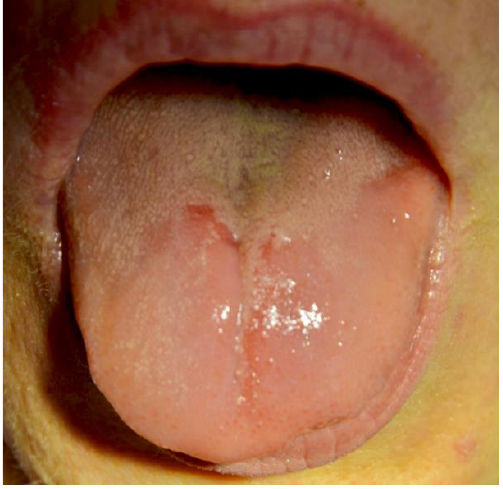
Figure 2. Oral atrophic mucositis.